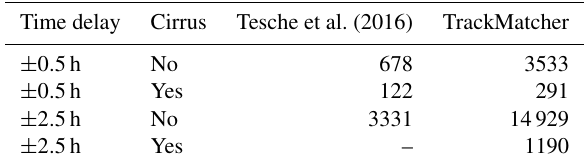
Table 3. Number of intercepts between aircraft tracks and the CALIPSO satellite track, for the connections by Tesche et al. (2016), for different time delays and cirrus presence at flight level, as identified in their study and this study. Note that Tesche et al. (2016) did not investigate embedded contrails for time delays larger than ± 30min.